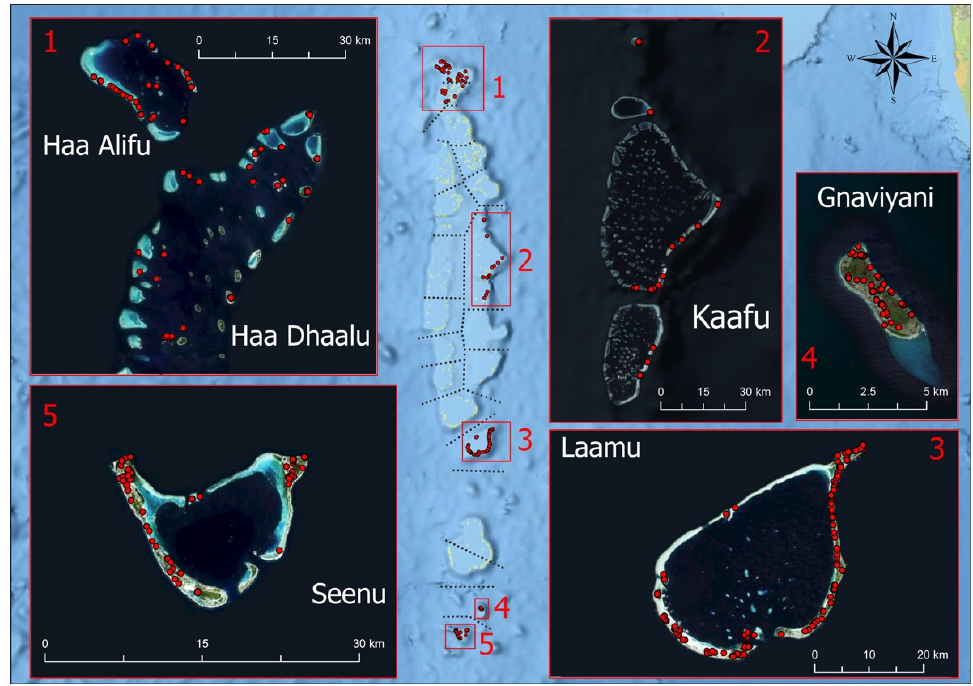
Figure 2. Map showing the areas of the Maldives where we have completed heritage field survey and documentation. Our field team has systematically surveyed all islands in each of the numbered atolls. Table 1. Total number of heritage site, feature, and object records produced over two phases of documentation in the Maldives and